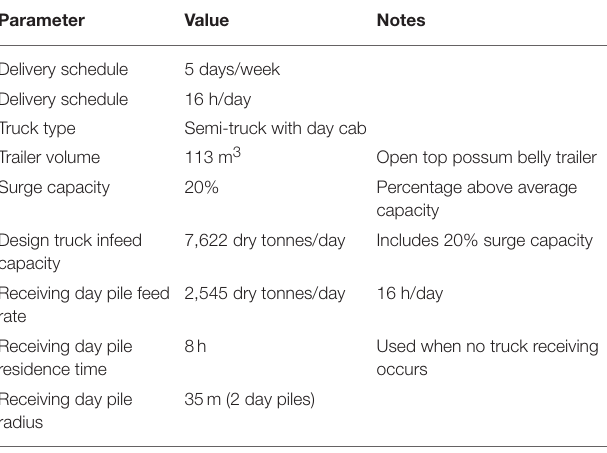
TABLE 3 | General design parameters for the preprocessing & storage operations of the chopped logistics system.